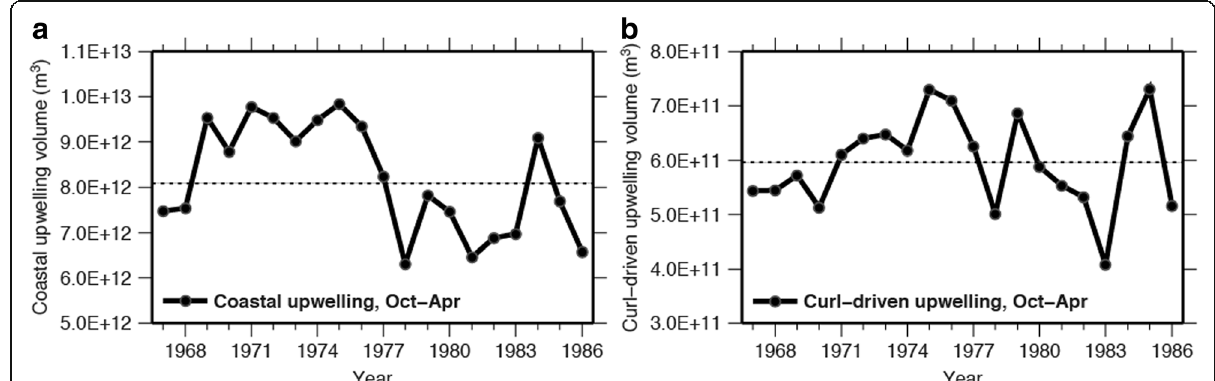
Fig. 15 Simulated time series of upwelling volumes for 1967 to 1986 of the historical simulation. a The coastal upwelling and b the curl-driven upwelling integrated from October to April. The values from October to December are grouped with the following year. Broken lines represent the values averaged over 1967 to 1986